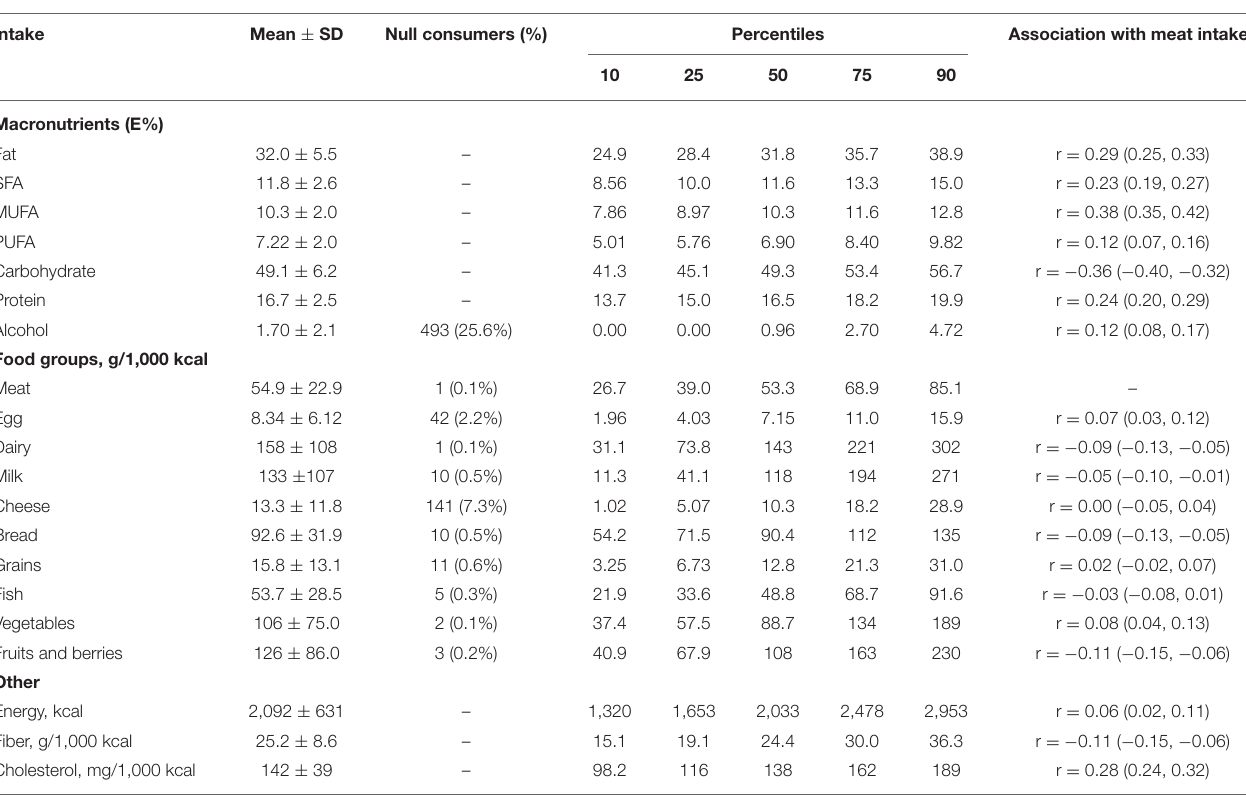
TABLE 2 | The daily dietary intake of the patients ( n =